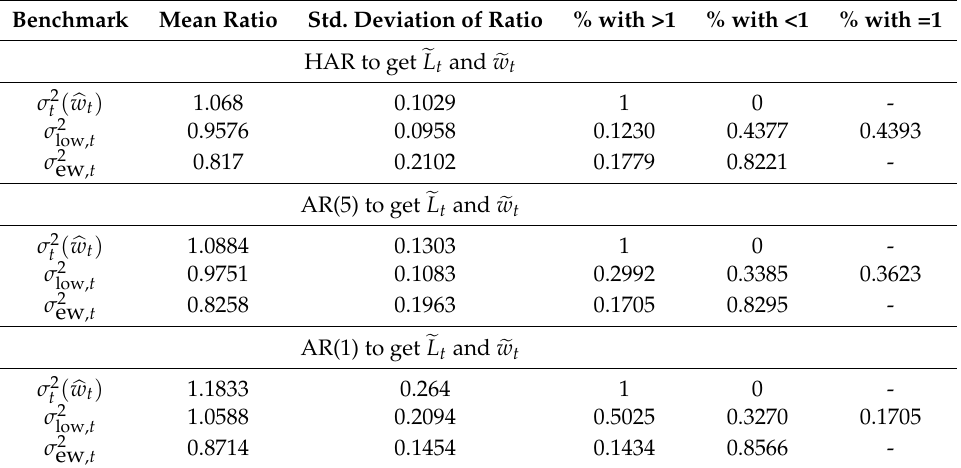
( (cid:101) w t , (cid:101) L t ) to different benchmark variances. Table 8. Ratios of σ 2 t Benchmark Mean Ratio Std. Deviation of